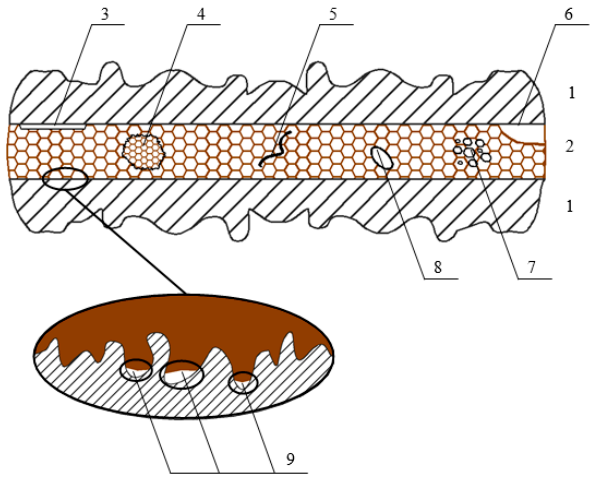
Figure 1. Technological defects of adhesive joints: 1 —joined materials, 2 —adhesive, 3 —de-adhesion, 4 —lack of solidification of the adhesive, 5 —crack, 6 —no adhesive, 7 —porosity, 8 —air bubble, 9 —no fill of irregularities in the surface.